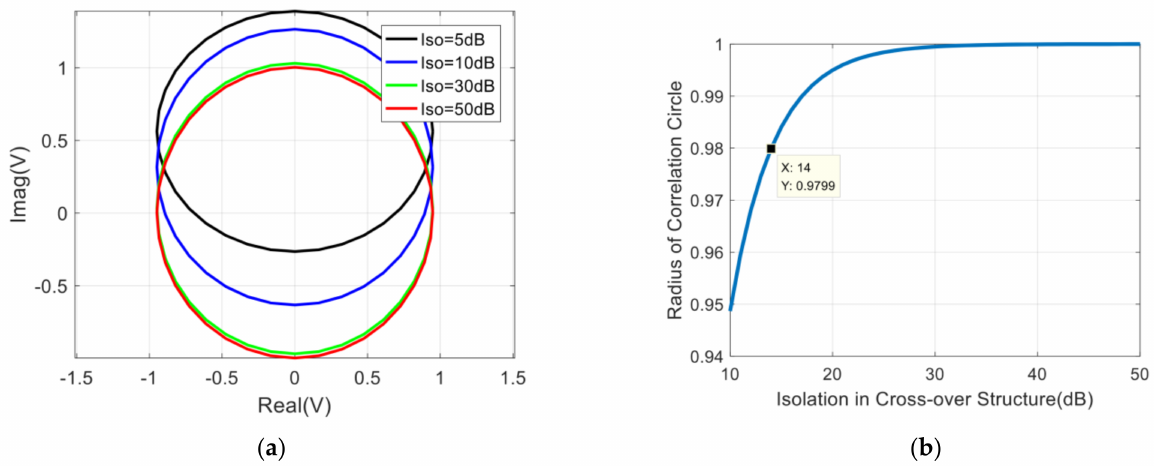
Figure 6. Influence of isolation in cross-over on correlation results: ( a ) The variation of the correlation circle with the isolation; ( b ) The variation of the radius of the correlation circle with the isolation.